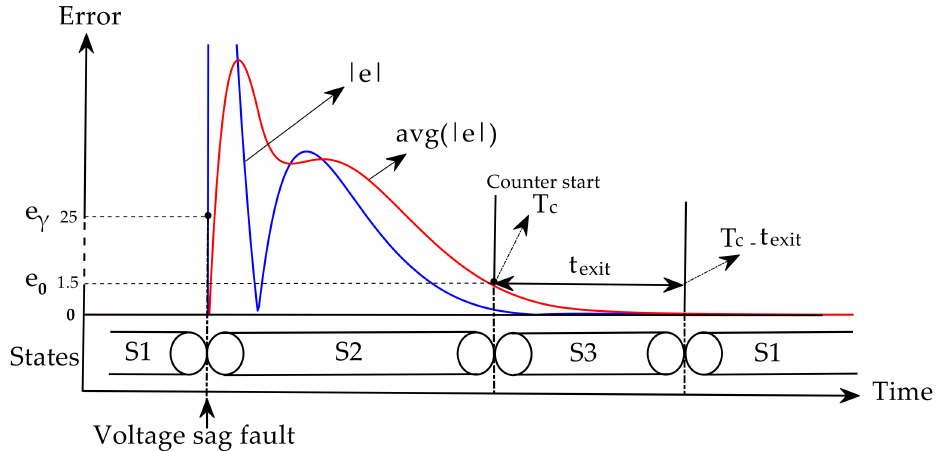
Figure 7. SOGI-FLL-EbA using e, | e | and avg ( | e | ) signals for improving the frequency response in face of voltage sags and swells.